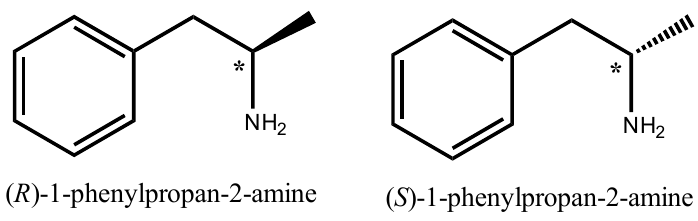
Figure 1. Structural formulas of d - (or R ) and l - (or S ) amphetamine.